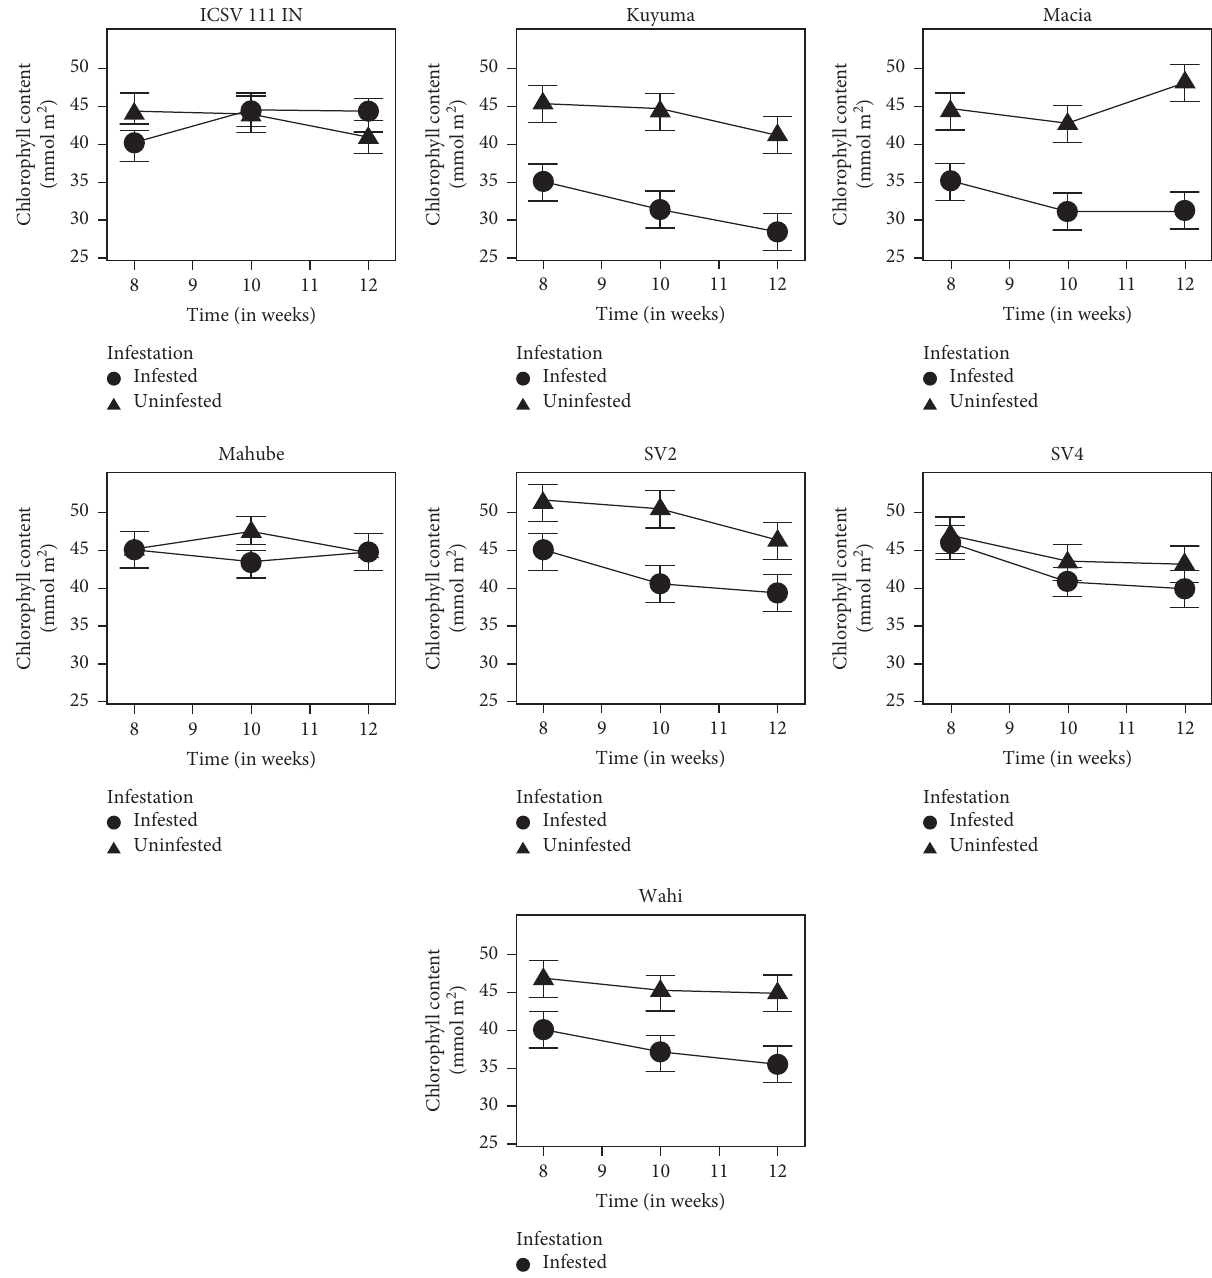
Figure 3: Effect of S. asiatica infestation on chlorophyll content of sorghum genotypes recorded in pot experiment. Error bars indicate LSD at p < 0 .